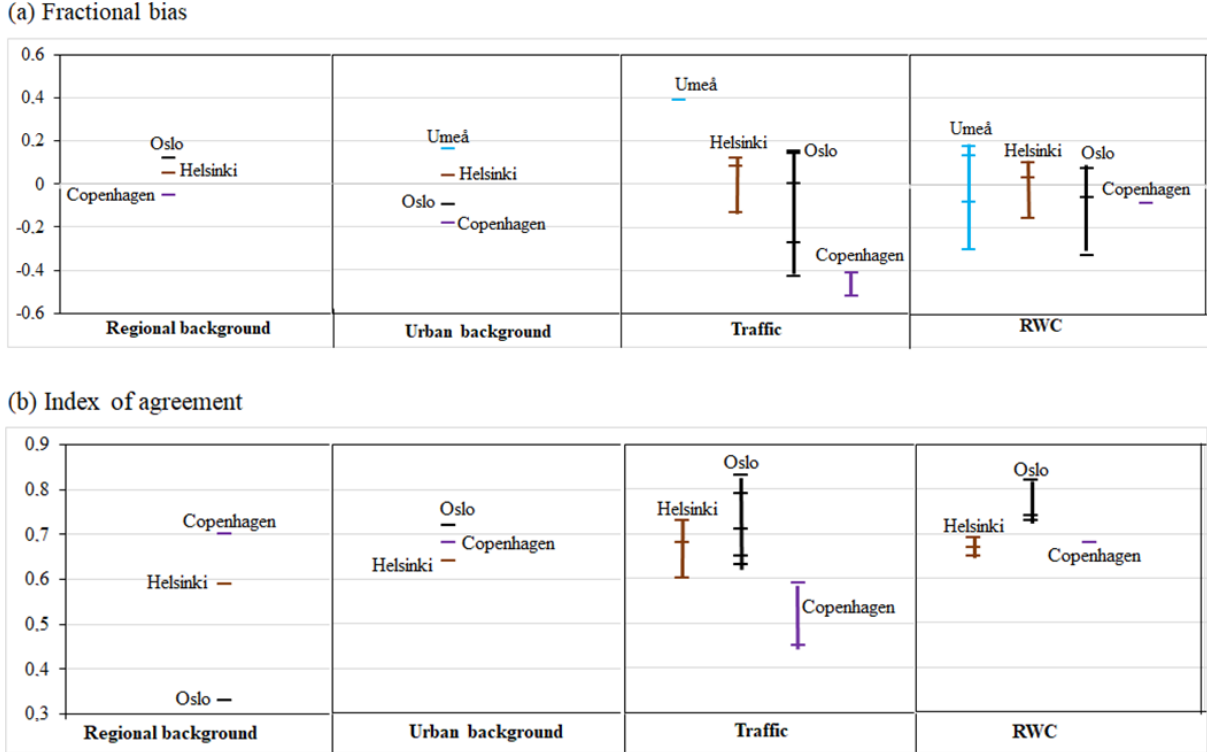
Figure 3. Values of two statistical model performance measures for the target cities, for various categories of stations. Panel (a) presents the fractional biases, and panel (b) presents the index of agreement. In the case of Oslo, we have selected three stations to be representative for RWC (Akerbergveien, Bygdoy Alle and Kirkeveien), although these were officially classified as traffic monitoring stations.